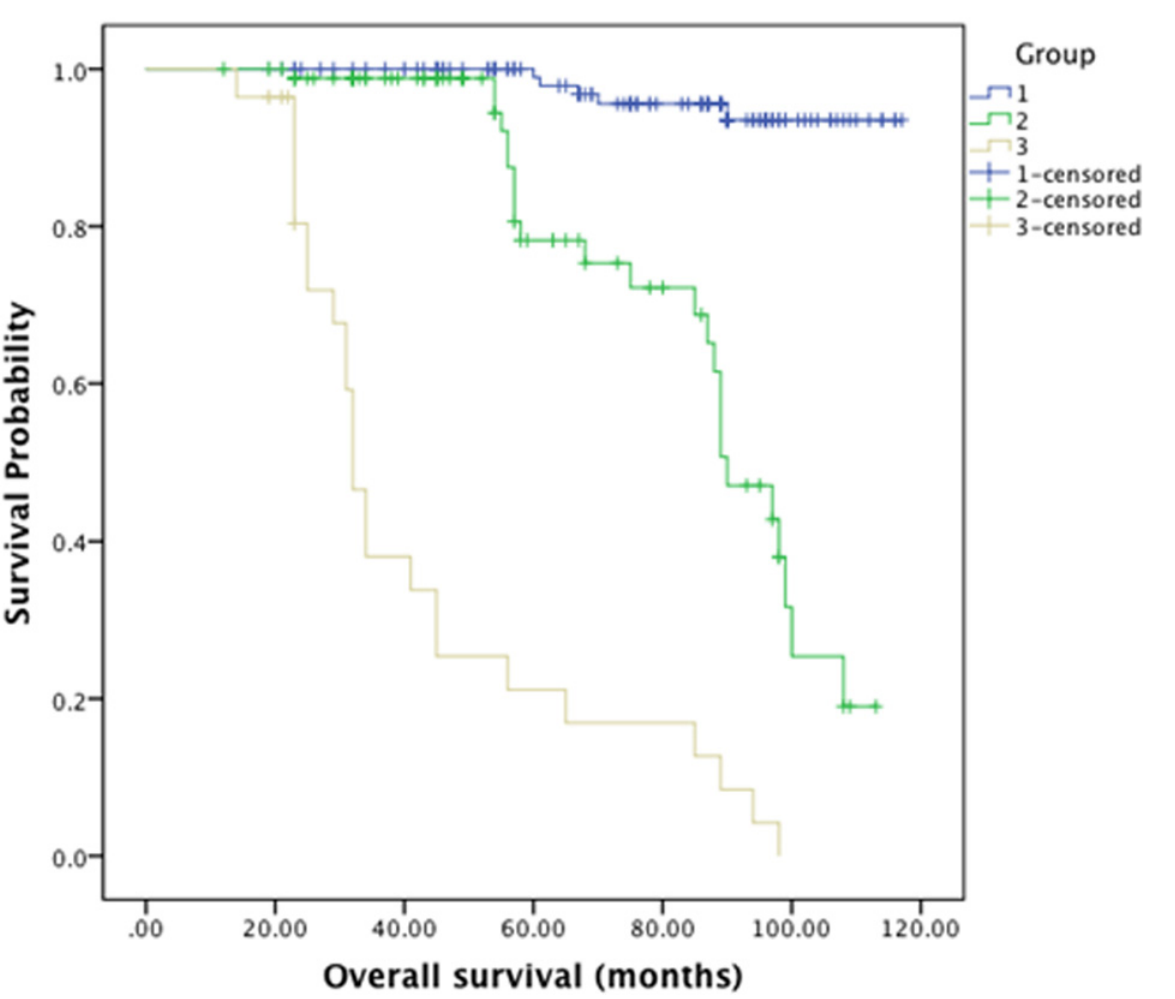
Fig 2. Kaplan-Meier Curve for Survival analysis among the group I, II and